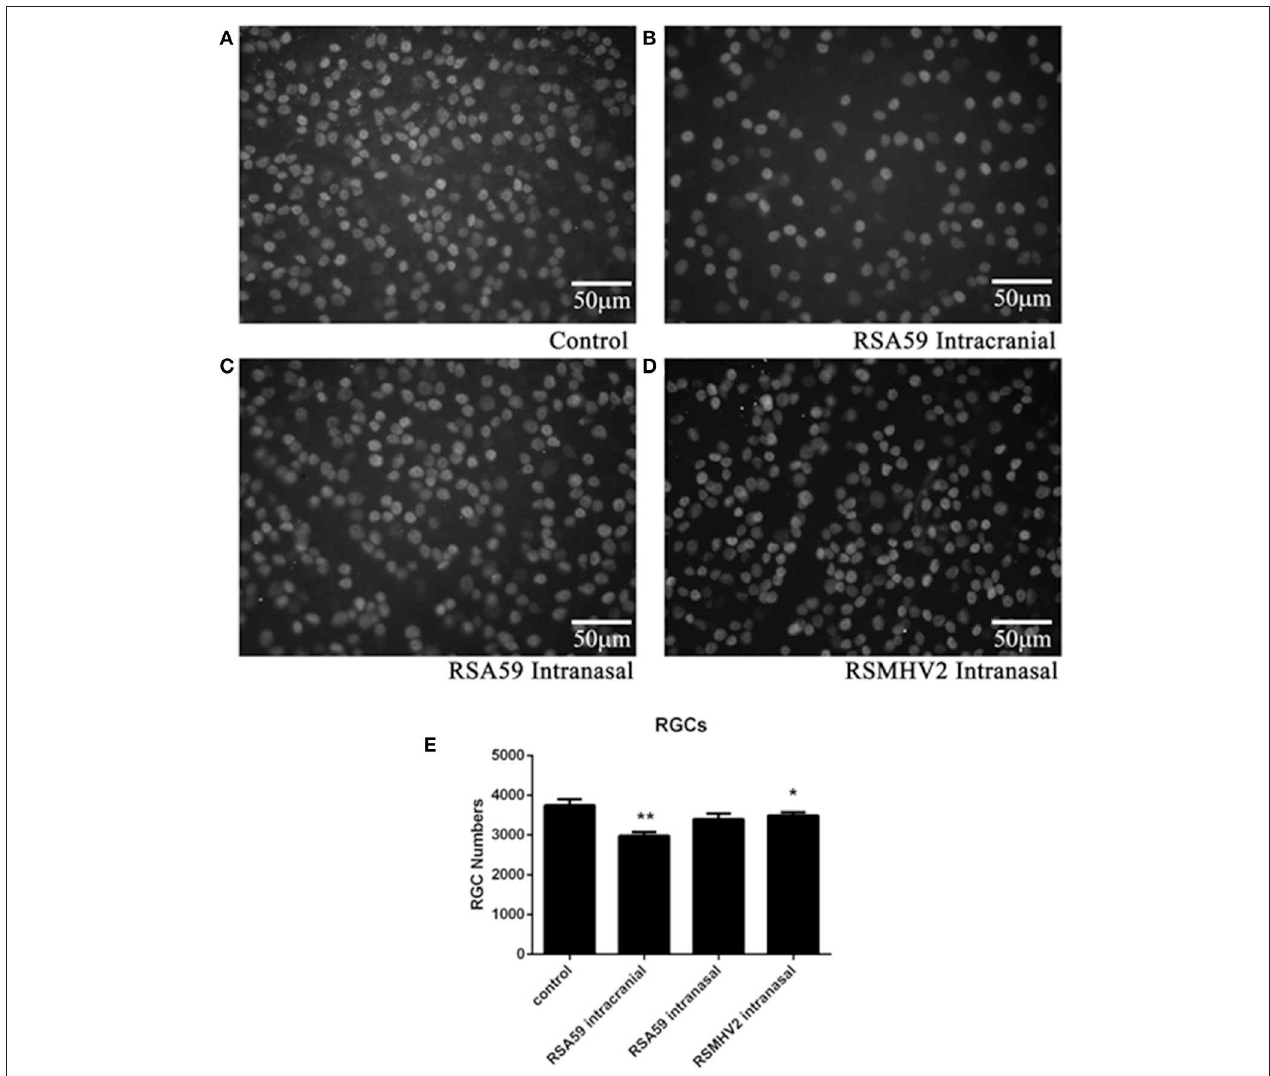
FIGURE 3 | RSA59 infection induces RGC loss. Representative photos illustrate the decreased RGC numbers in eyes of mice inoculated intracranially with RSA59 (B) compared to mock-infected control mice (A) . Mice inoculated intranasally with RSA59 (C) or RSMHV2 did not show RGC loss (D) (scale bar = 50 µ m). The total number of labeled RGCs present in 12 standardized retinal fields was counted. The average number of surviving RGCs/eye ( n = 6/group) shows intracranial RSA59 induced a significant decrease in RGC numbers compared to control mice (** p < 0.01). Neither RSA59 nor RSMHV2 induced RGC loss compared to control mice when administered intranasally. RGC numbers in RSMHV2-infected mice were significantly higher than in mice intracranially inoculated with RSA59 (* p < 0.05) (E) . Data comparisons were done by one-way ANOVA and Tukey’s Multiple Comparison post-hoc testing with GraphPad Prism 6.0